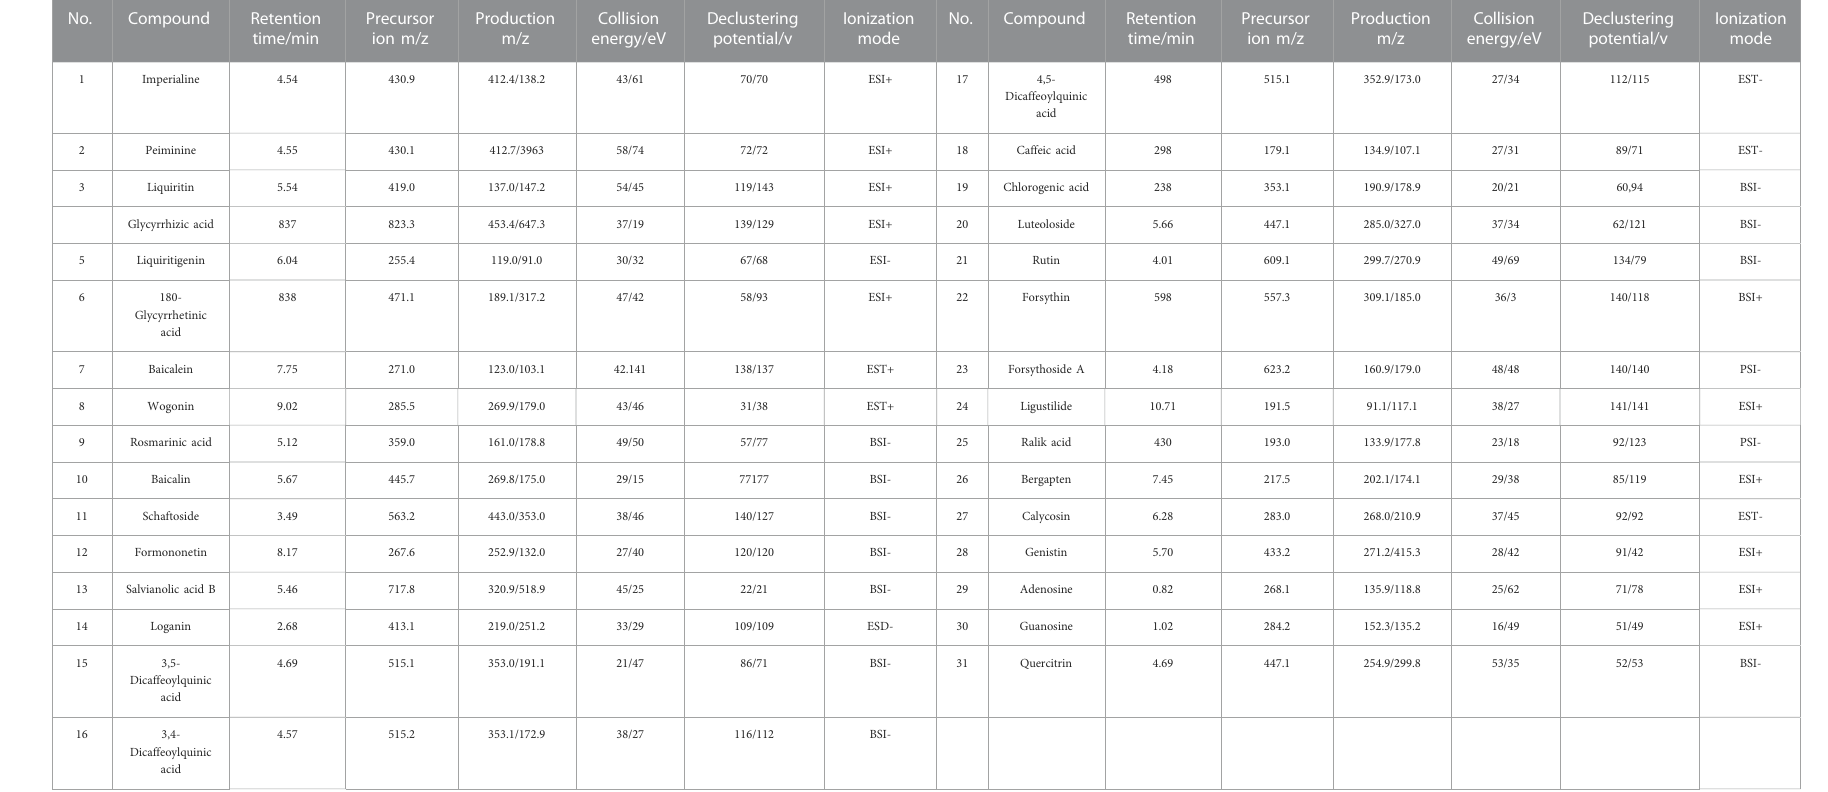
TABLE 1 MS analysis parameters of 31 detected